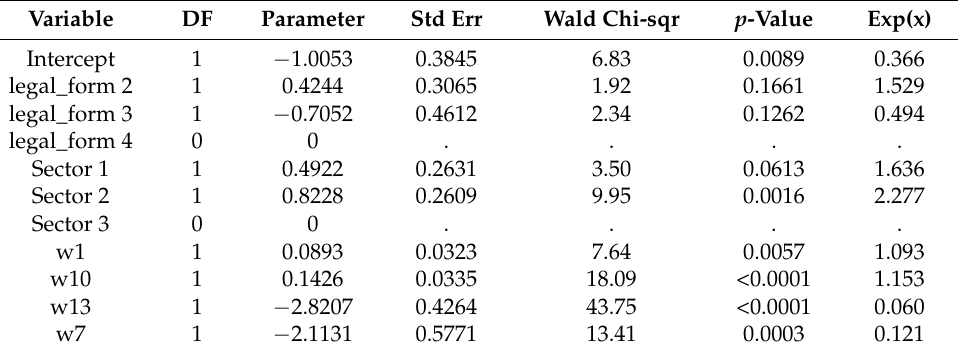
Table 1. Results of estimation of logistic regression with interval variables.